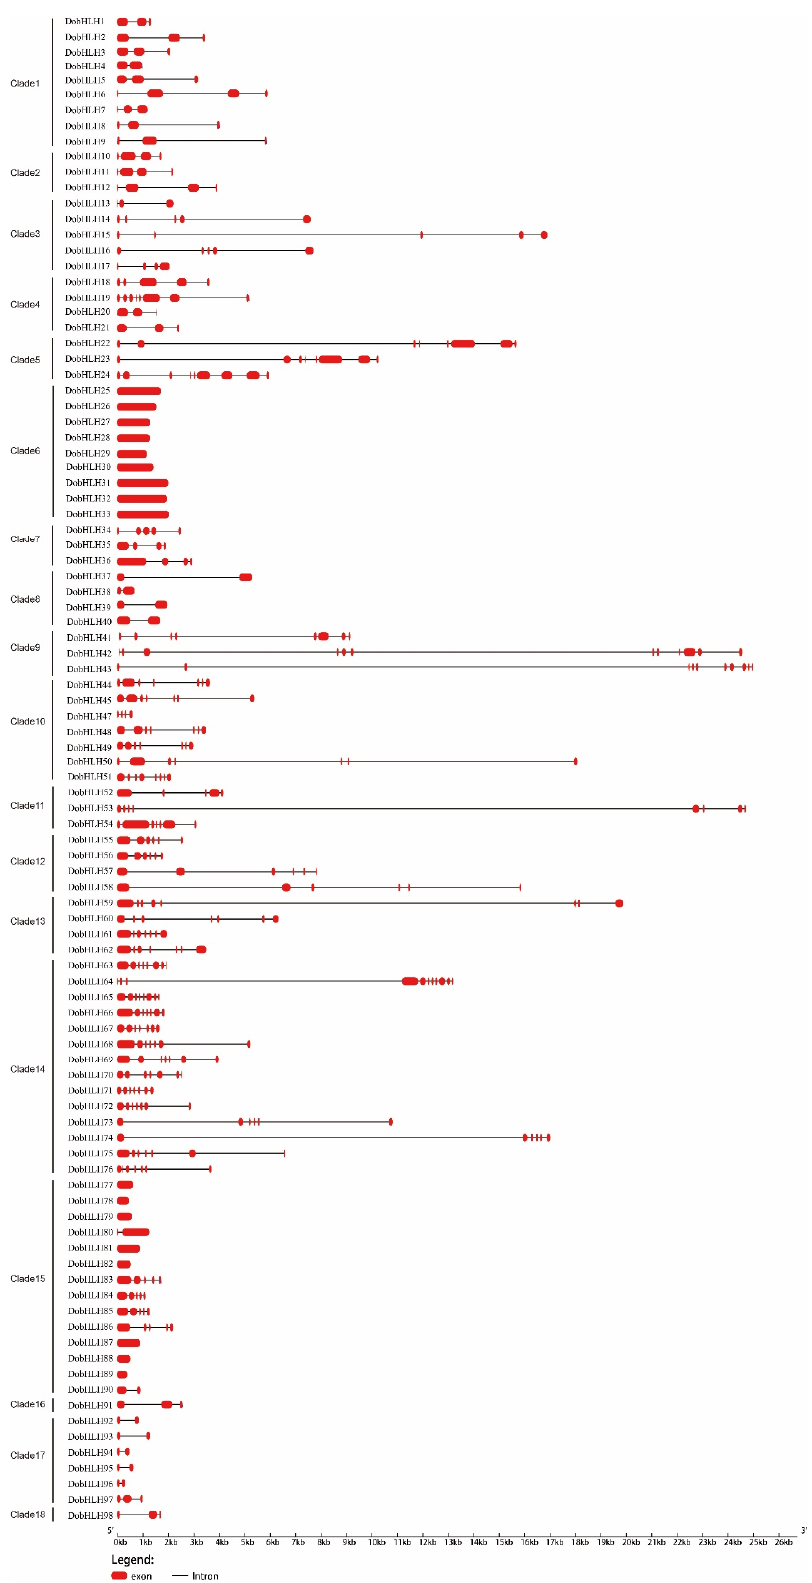
Figure 2. The gene structures of DobHLH genes in D. o ffi cinale . The exon-intron structures of 98 DobHLH genes were obtained with GSDS 2.0. The red rectangles and black lines indicate exons and introns, respectively, according to their